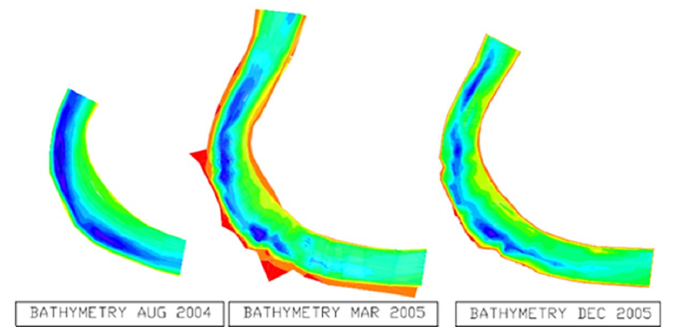
Figure 9. Sinú River, Trementino: evidence of the almost immediate effect of the displacement of the thalweg through the submerged panel field installed.